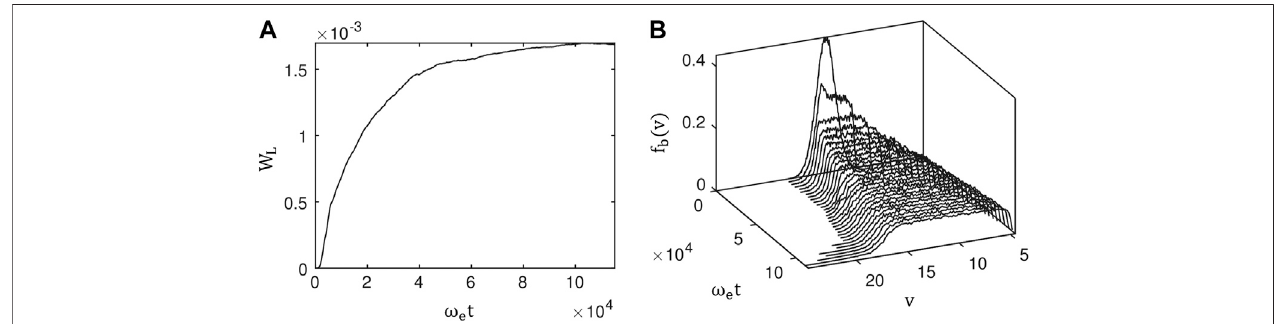
FIGURE1| Adapted fromKrafftetal.(2015):Resultsfromone-dimensionalsimulationsdescribingquasi-linearrelaxationofanelectron beam. (A) Timevariationof thenormalized energydensityofbeam-generatedLangmuirwaves( W L ).And, (B) evolutionofthebeamdistributioninvelocityspace( v )asafunctionoftime.Here, v isin (cid:11)(cid:11)(cid:11)(cid:11)(cid:11)(cid:11)(cid:11)(cid:11) (cid:12) the unit of electron thermal velocity de fi ned as V e , th (cid:1) k B T e / m e . The simulation corresponds to choices of n 0 (cid:1) 5 × 10 6 m − 3 , T e (cid:1) 20eV, n b / n 0 (cid:1) 5 × 10 − 5 and v b (cid:1) 2keV, comparable to observations in the solar